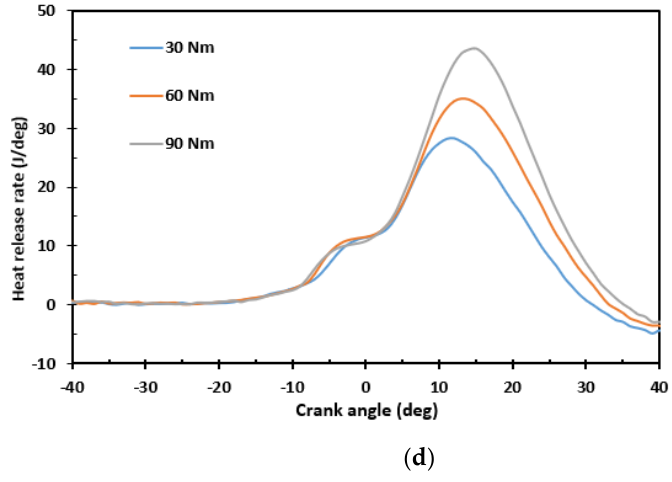
Figure 4. Heat release rate for ( a ) D100, ( b ) D95E5, ( c ) D90E10, and ( d ) D85E15.